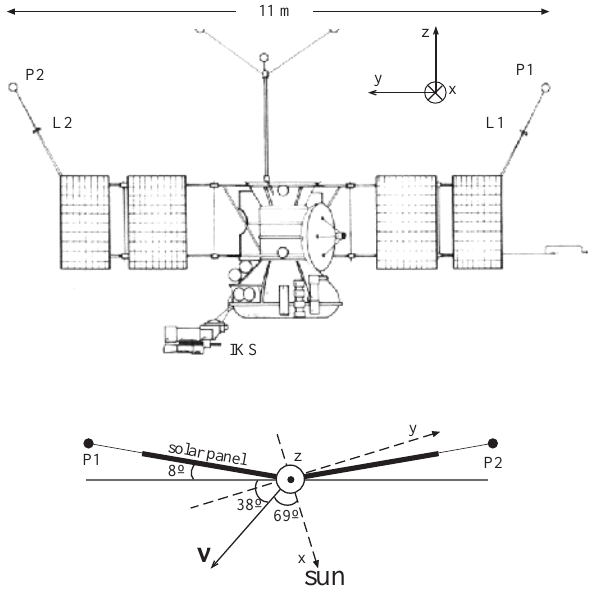
Fig. 1. Top: Outline of the Vega spacecraft showing the locations of the APV-V sensors and IKS instrument. Bottom: Orientation of the satellite structure relative to its velocity vector and the Sun (top view).